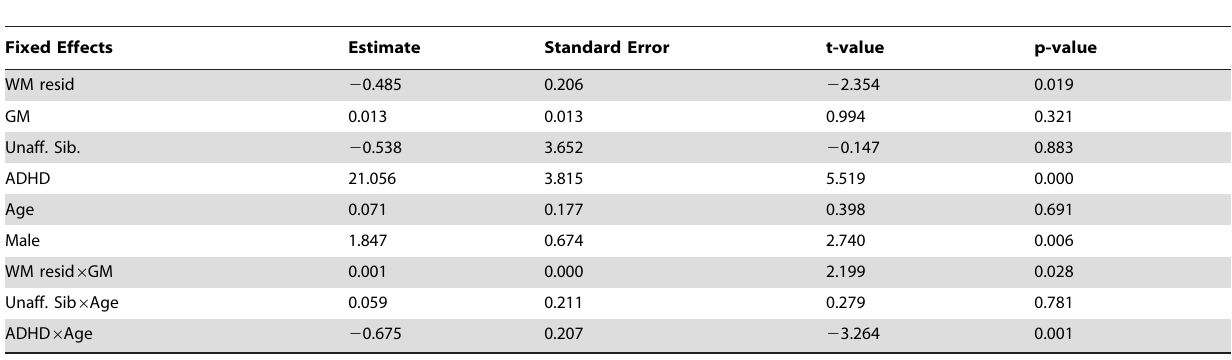
Table 2. Final, generalised mixed-effect model showing fixed effects for ASD score modelled against white matter residual and grey matter